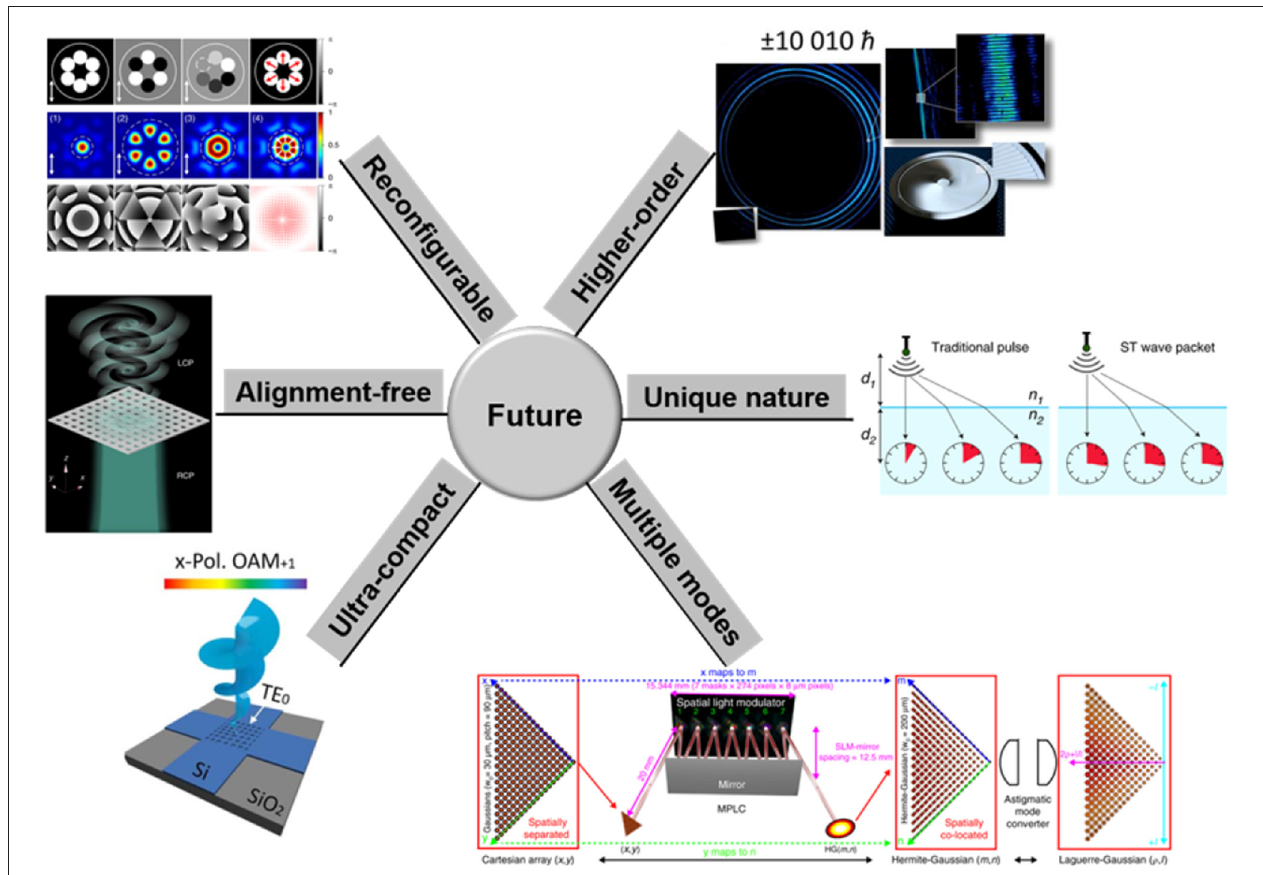
FIGURE 11 | Future challenges and prospects for generation and detection of structured light beams. Reprinted from Bhaduri et al. [34], Lin et al. [52], Zhou et al. [56], Wang et al. [73], Fontaine et al. [78], and Fickler et al.